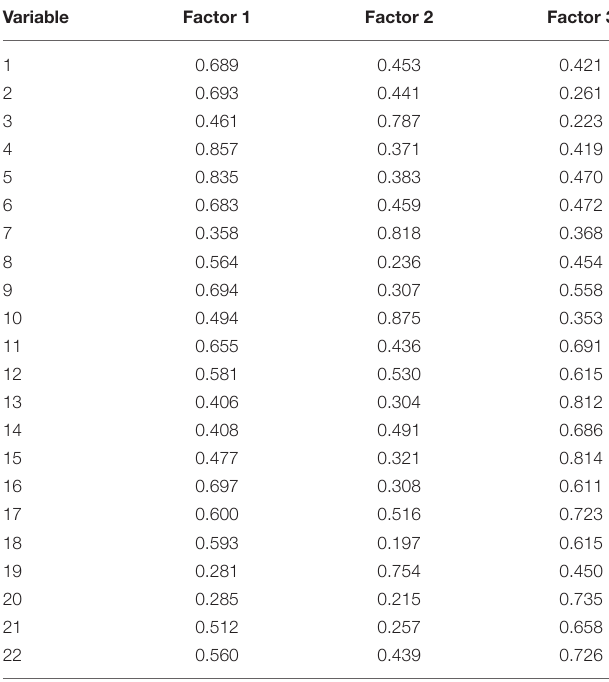
Structure matrix. Polychoric correlation matrices: 500. Promax rotation, Kappa value of 4. Number of components: